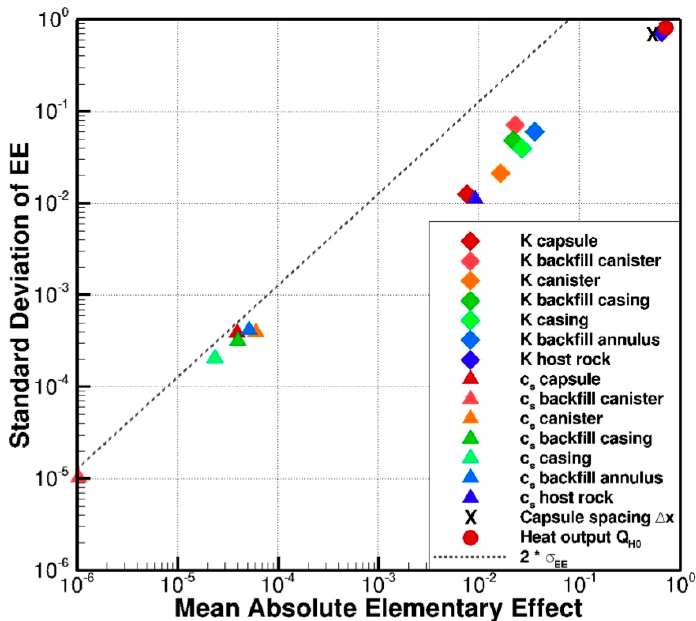
Figure 4. Mean absolute elementary effect and standard deviation for each parameter examined using the Morris global sensitivity analysis.